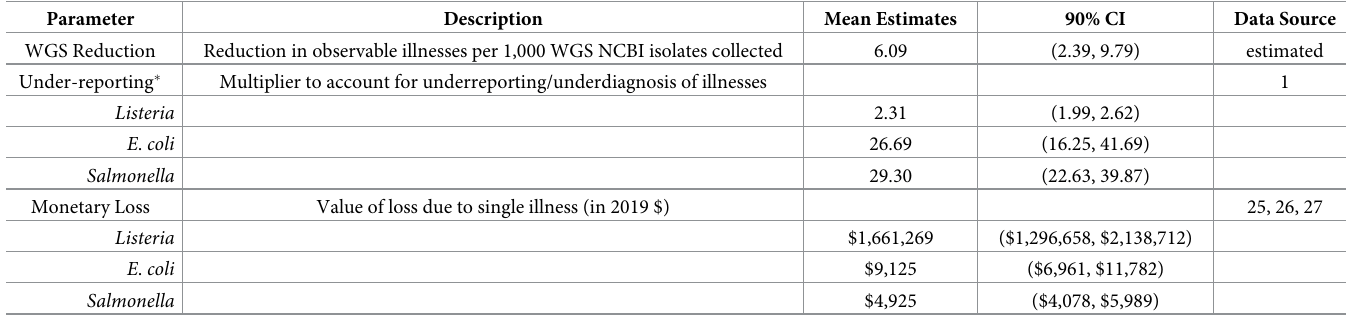
Table 3. Benefits